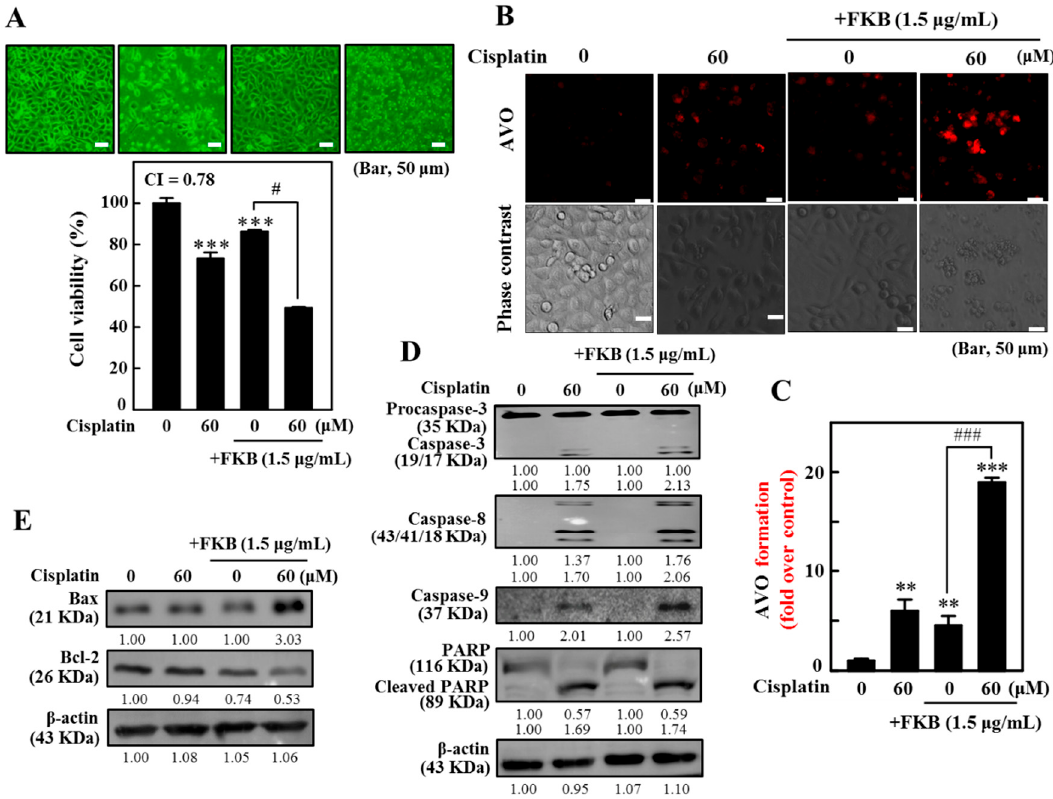
Figure 11. The FKB enhances / exacerbates / augments apoptosis and autophagy induced by cisplatin in AGS cells. Cells were treated for 24 h in combination with FKB (1.5 µ g / mL), and / or cisplatin (60 µ M). ( A ) Assessing cell viability using an MTT assay. According to the Chou and Talalay method, the e ff ect of individual or co-treatments of both FKB and cisplatin on AGS cell survival and proliferation propagation were determined after the incubation period. The low value of the combination index (CI) signifies a greater synergistic e ff ect. ( B , C ) The formation of AVOs were visualized through a fluorescent microscope (100 × magnification, red filter). Quantification of AVO formation. ( D ) Western blot study of